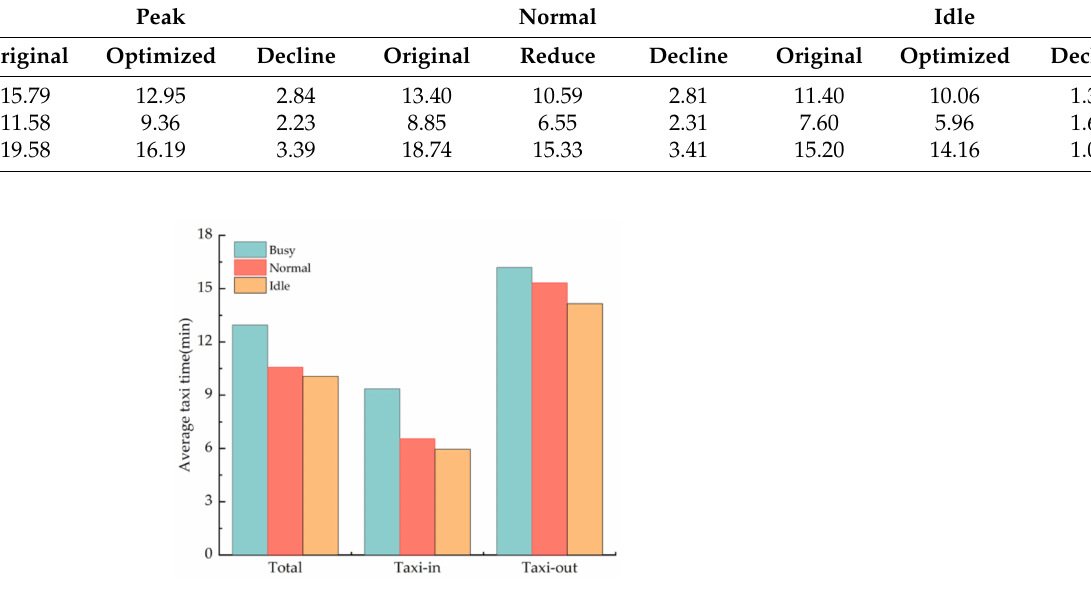
Figure 8. Comparison of average time of taxi-in, taxi-out, and total taxi time in three scenarios after optimization.